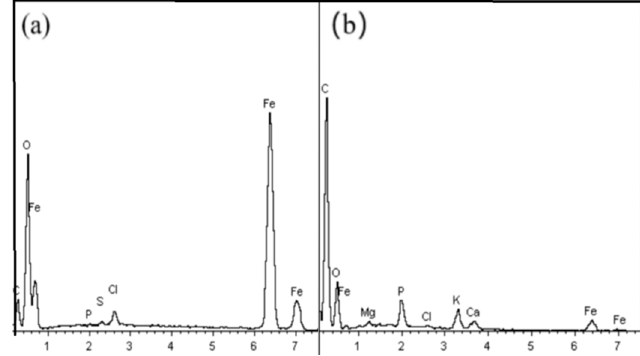
Figure 10. EDS diagram of NICLS surface before ( a ) and after ( b ) reaction.